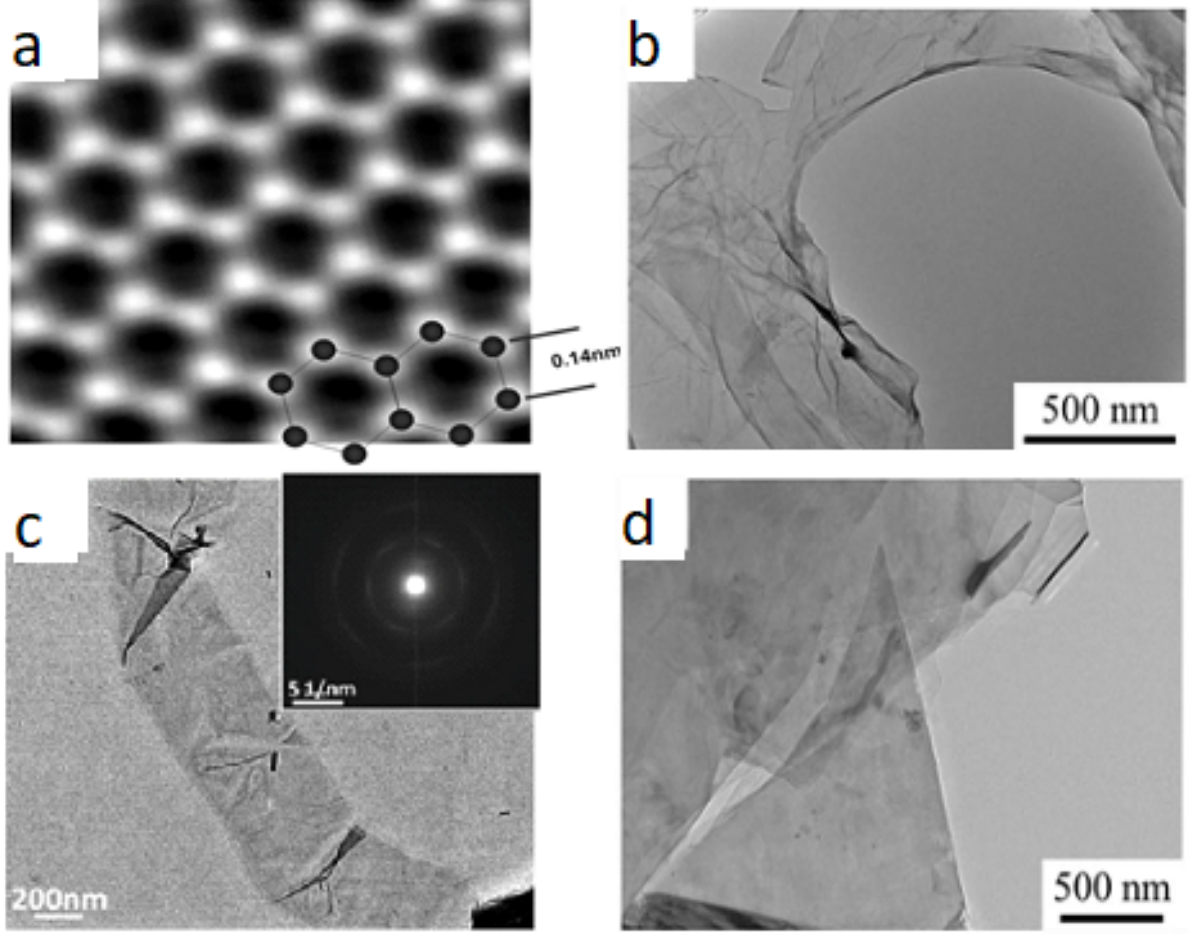
Figure 3: TEM images of (a) a graphene sheet, (b) GO, (c) GNR, and (d) GNP. Reproduced from References [52, 86–88], respectively.